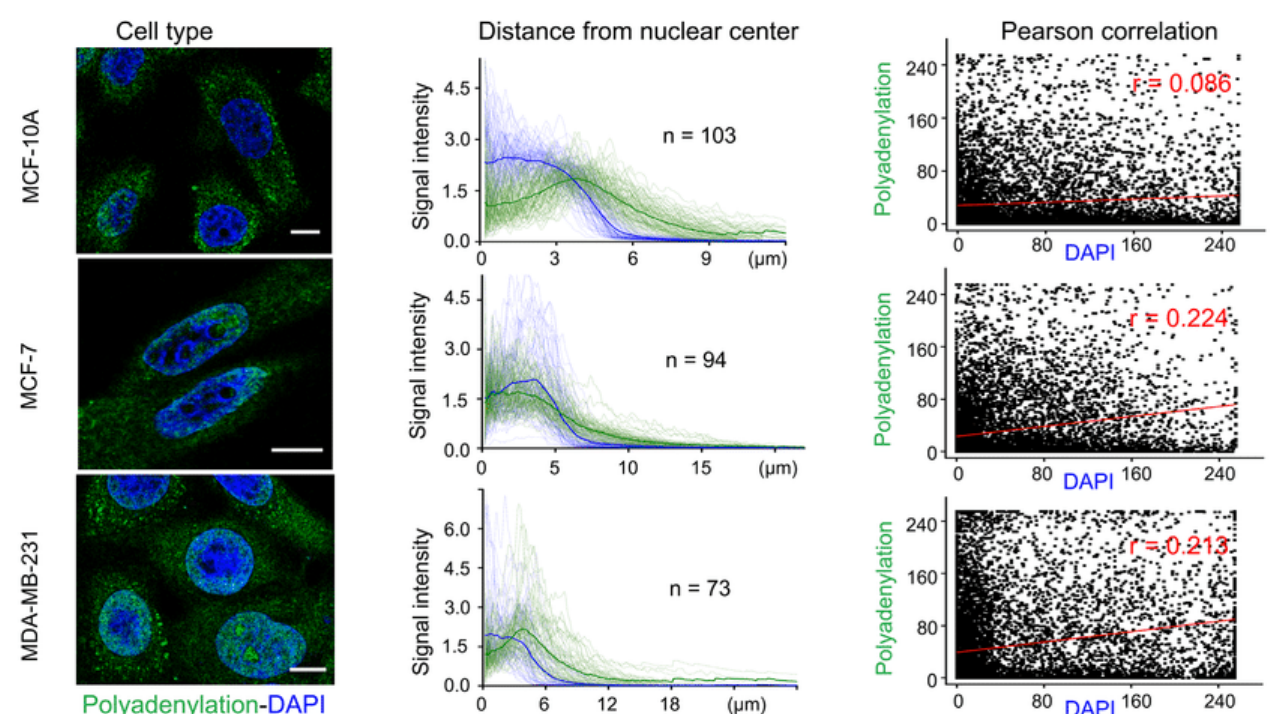
Figure 7. Specific organization of RNA polyadenylation in specific cells. The pictures in the left column visualize three types of cells, in the cells is polyadenylation identified with green-fluorescent dye and DAPI with blue. The middle column shows signal intensity of DAPI and adenylation as a function for the distance of polyadenylation from the nuclear center, and in the right column is this distance interpreted by Person correlation [59].